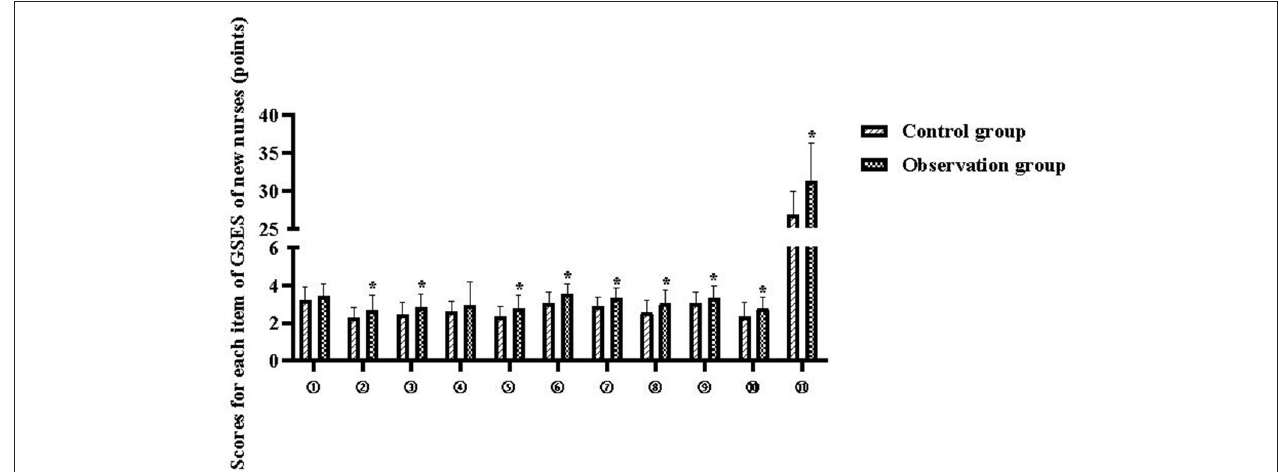
FIGURE 3 | Each item scores of GSES of new nurses. Compared with the control group, * P < 0.05.